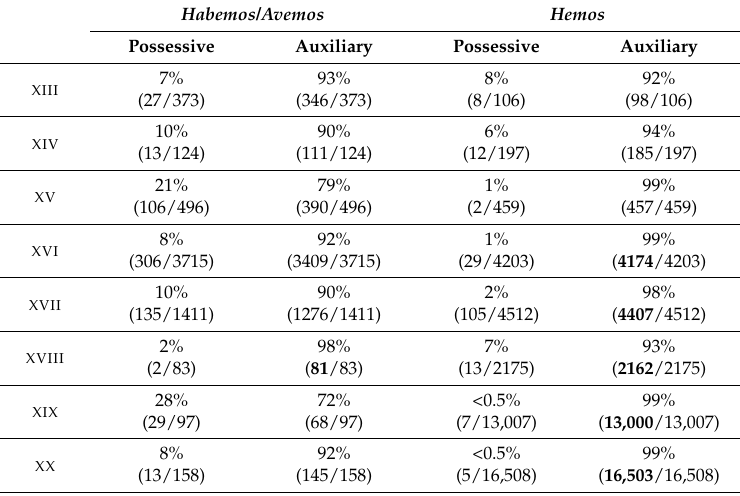
Table 1. Possessive meanings vs. habemos ( avemos ) and hemos as an auxiliary